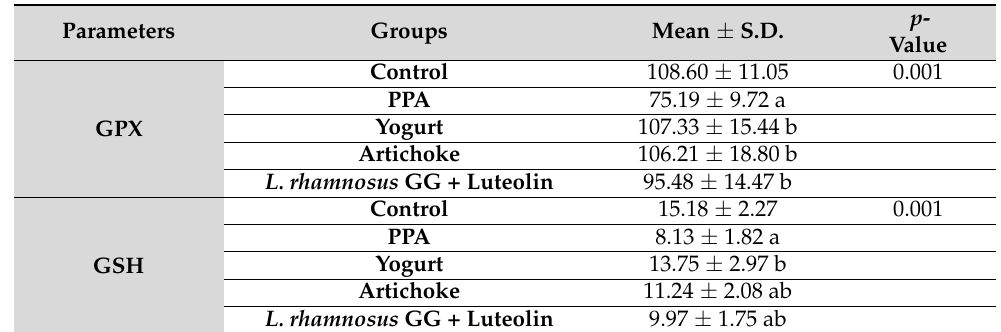
Table 1. Effect of nutrition with yogurt, artichokes, and combined L. rhamnosus GG + luteolin on levels of GPX1 (U/mg protein), GSH ( µ g/mg protein), and GABA (Pg/mg protein) in the brain homogenates of the PPA-induced rodent model of